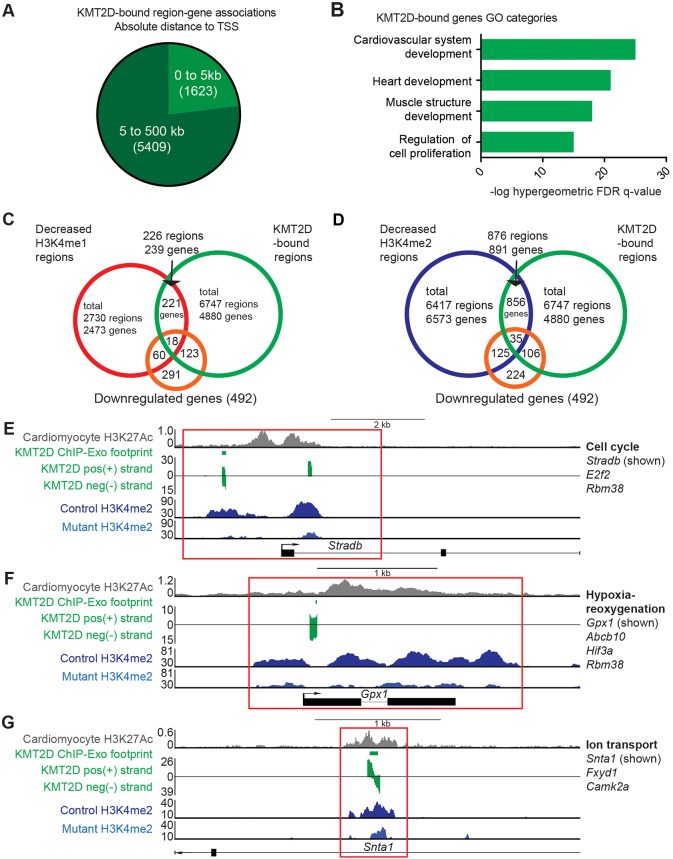
KMT2D binds to promoter and enhancer regions of genes related to cell cycle, hypoxia-reoxygenation and ion transport. (A) 6747 regions bound by KMT2D in in vitro cardiomyocytes are assigned to 4880 genes by proximity using Stanford GREAT. 1623 region-gene associations are within 5 kb of a TSS and 5409 region-gene associations are 5 to 100 kb of a TSS. (B) GO categories of KMT2D-bound genes are over-represented for heart development and cell proliferation. (C) Venn diagram showing that only a subset of 18 genes overlap between 492 downregulated genes in E11.5 Tnnt2::Cre;Kmt2dfl/fl hearts and regions bound by KMT2D with decreased H3K4me1 levels (FDR<0.1). (D) Venn diagram showing that only a subset of 35 genes overlap between 492 downregulated genes in E11.5 Tnnt2::Cre;Kmt2dfl/fl hearts and regions bound by KMT2D with decreased H3K4me2 levels (FDR<0.1). (E) Representative browser tracks of KMT2D ChIP-Exo positive strand, negative strand, and resulting footprint shows that KMT2D binds to the TSS of the cell cycle gene Stradb in cardiomyocytes, which corresponds to a region with decreased H3K4me2 (FDR<0.1) in mutant hearts (red box). (F) KMT2D binds to the TSS of the antioxidant enzyme gene Gpx1 in cardiomyocytes, which corresponds to a region with decreased H3K4me2 (FDR<0.1) in mutant hearts (red box). (G) KMT2D binds to the intronic H3K27Ac-enriched enhancer of the ion transport gene Snta1 in in vitro cardiomyocytes, which corresponds to a region with decreased H3K4me2 (FDR<0.1) in mutant hearts (red box). The H3K27Ac browser track y-axis corresponds to reads per million; for the other tracks the y-axis corresponds to input-normalized tag density.